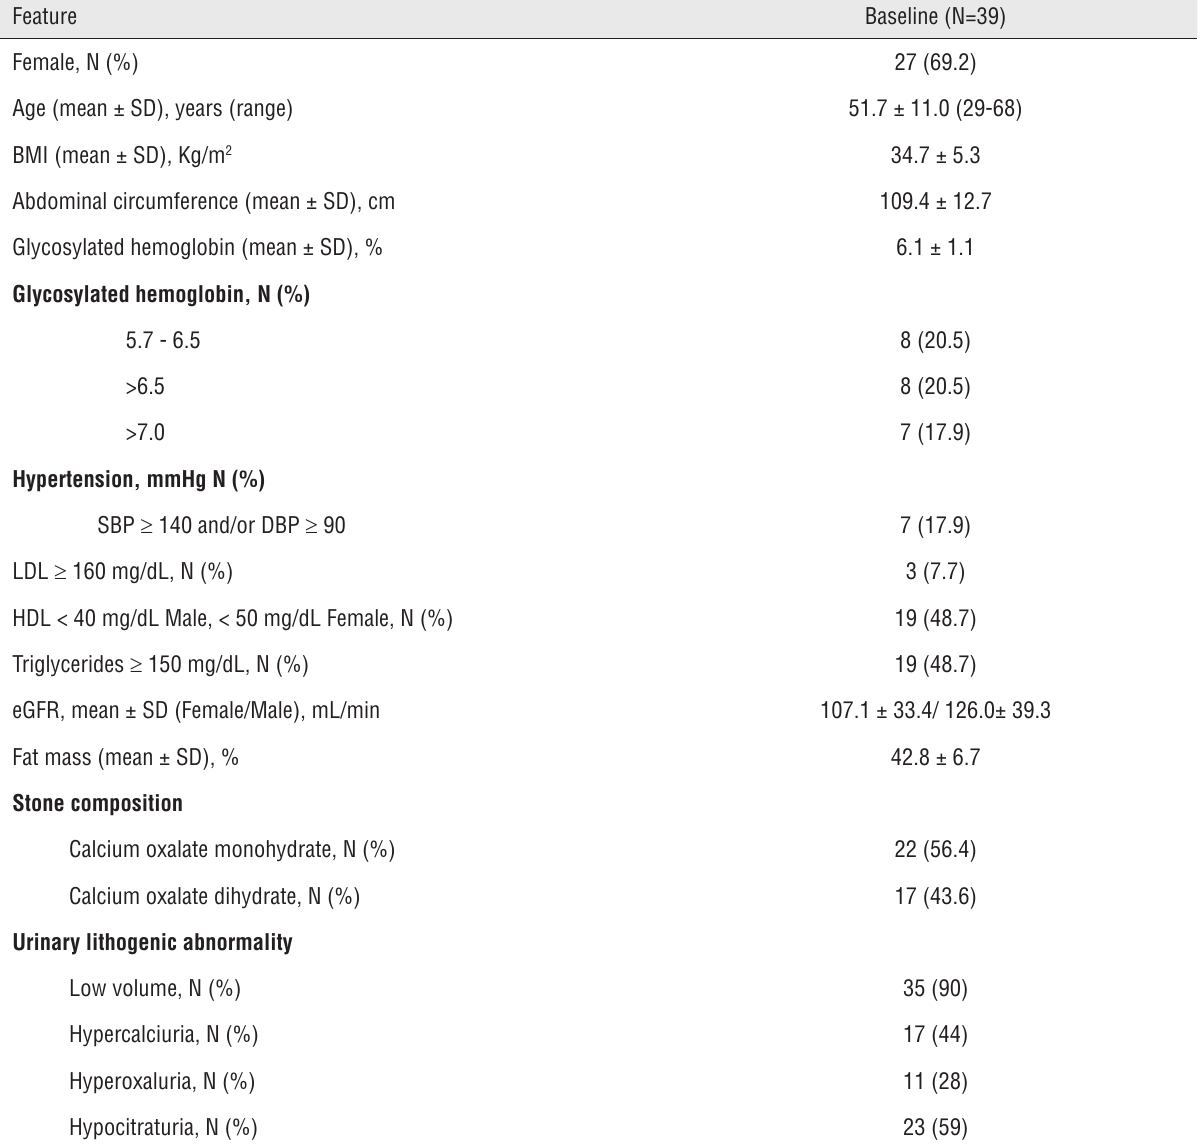
Table 1 - Baseline characteristics of the study